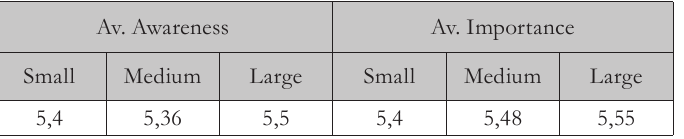
Tab. 3 – Awareness and Independence of Intellectual Capital depending on Size. Source: Own processing,